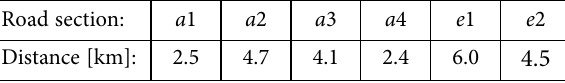
Table 4. Road colours and their corresponding average speed Colour: green yellow red Speed [m/s]: